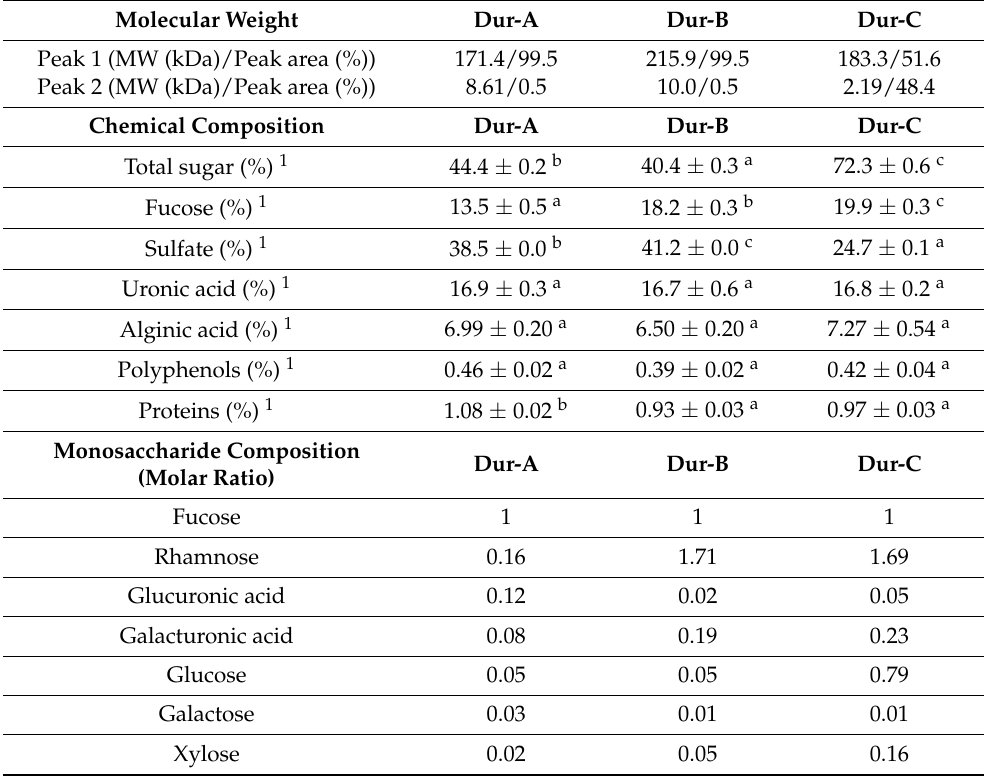
Table 2. Physicochemical analyses for Dur-A, Dur-B, and Dur-C. Molecular